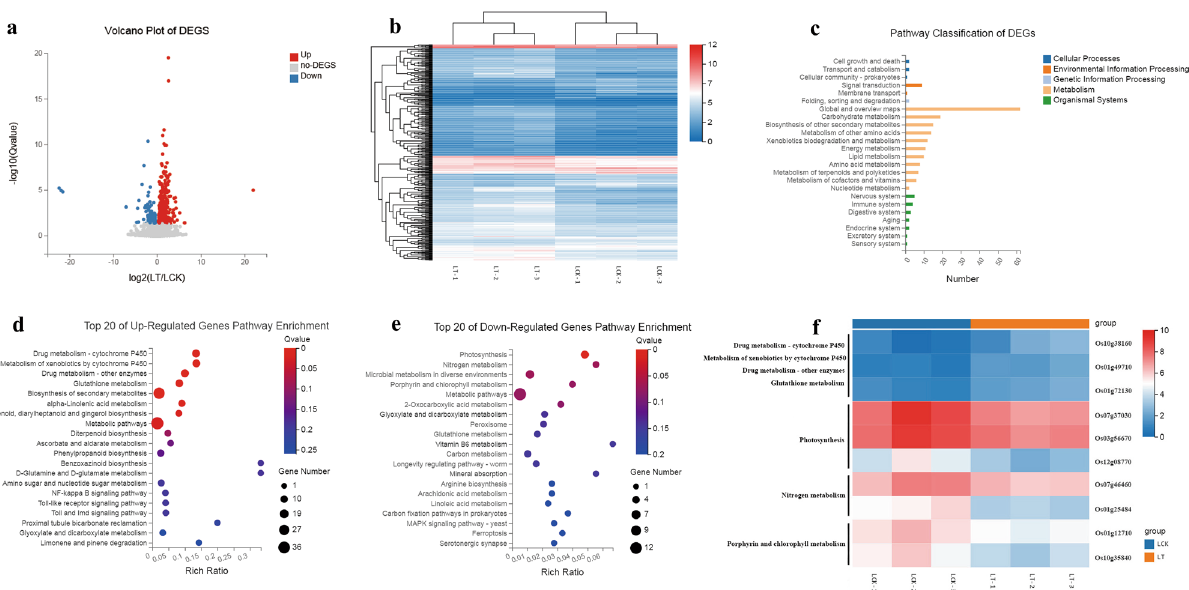
Figure 6. RNA-Seq Analysis of the O. sativa under two treatment models. ( a ) The volcano plot of DEGs. Different colors represent different gene expression trends. ( b ) Hierarchical cluster analysis of the significantly changed DEGs. The color key represents FPKM-normalized log2-transformed counts. ( c ) KEGG pathway classification analysis of DEGs. ( d ) Top 20 KEGG pathway enrichment analysis of up-regulated DEGs. The colors are shaded according to the Q-values level, as shown in the color bars gradually from low(red) to high(blue); the size of the circle indicates the number of DEGs from small (less) to big (more); the same of next figure. ( e )Top 20 KEGG pathway enrichment analysis of down-regulated DEGs. ( f ) The expression of key DEGs in key pathways. The color key represents FPKM-normalized log2-transformed